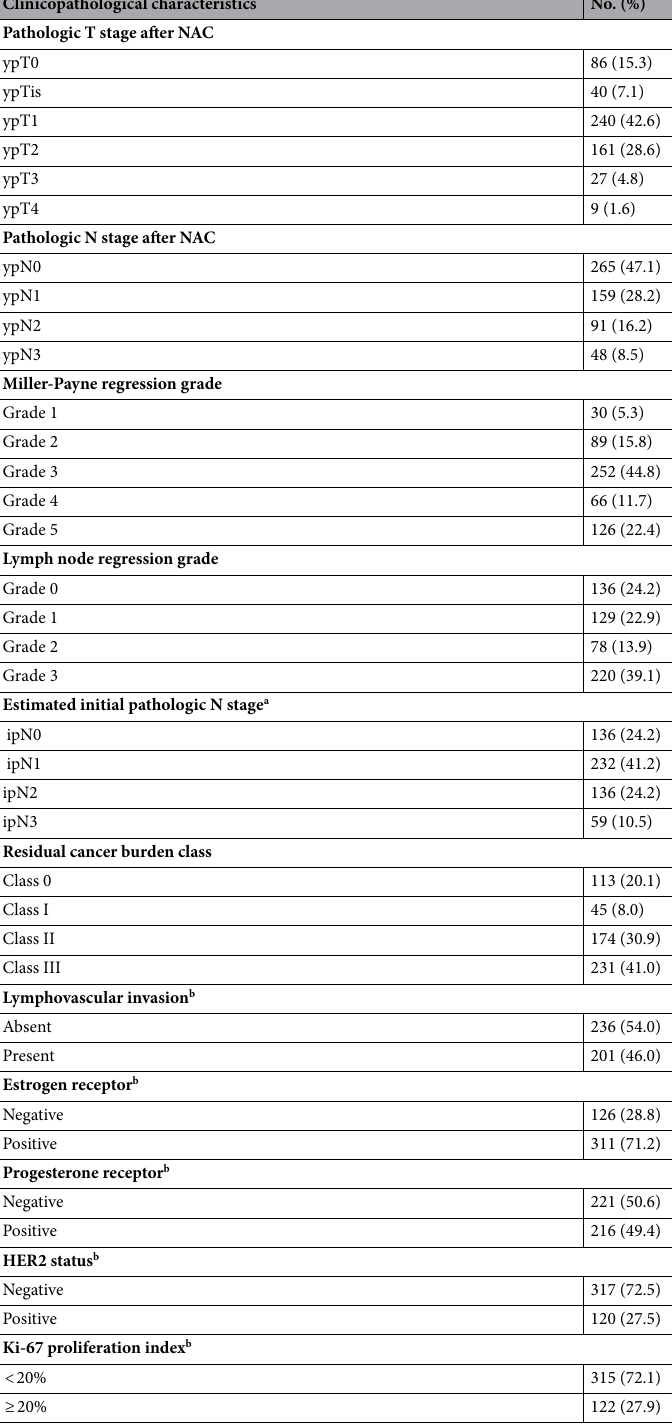
Table 2. Clinicopathological characteristics of tumors after neoadjuvant chemotherapy. NAC neoadjuvant chemotherapy. a Initial pathologic N stage was estimated from the sum of number of positive lymph nodes and those with a regressive change. b These characteristics were evaluated in cases with residual disease in